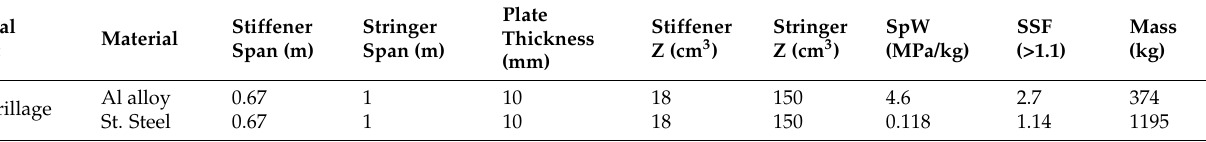
Table 6. Best parametric combinations by material in terms of SSF, SpW and mass.